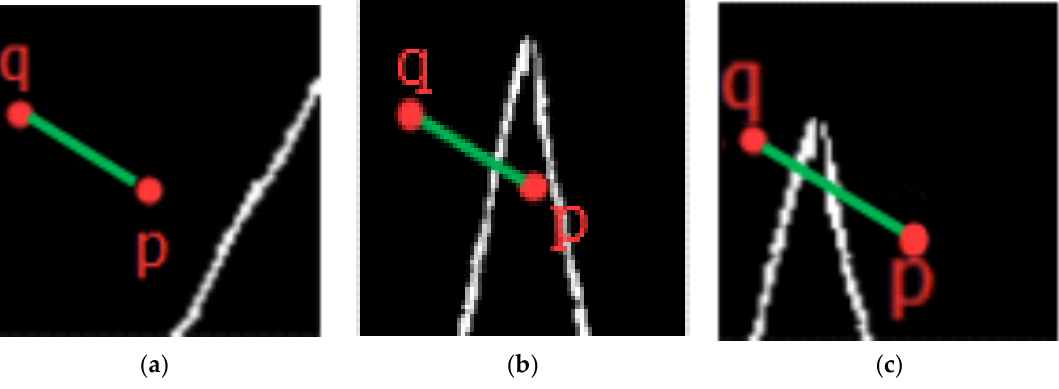
Figure 2. Distinguish of two pixels near edge.